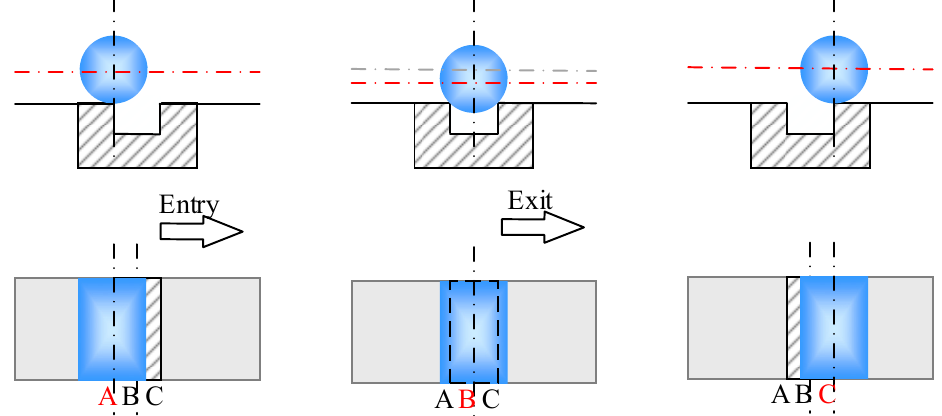
Figure 1. Schematic diagram of dual-impulse behavior caused by penetrating damage.